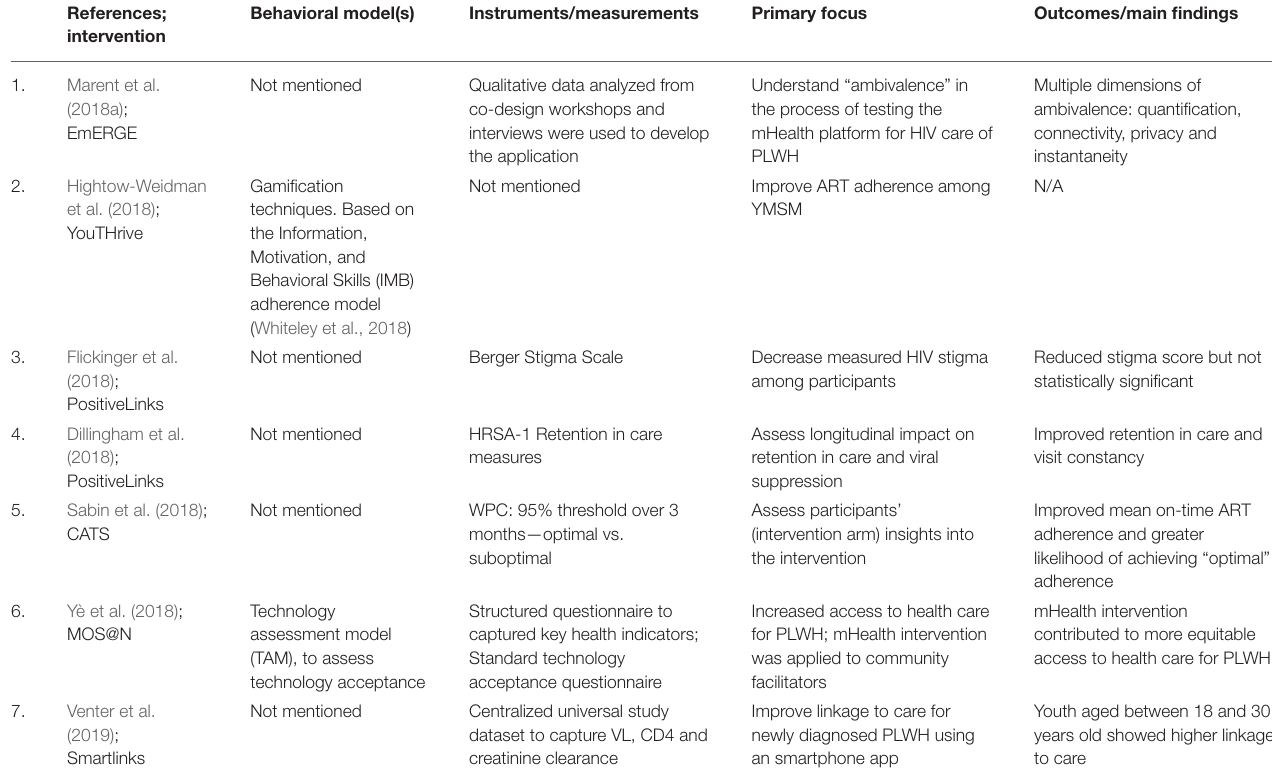
TABLE 3 | Summary of behavioral models, instrumentation, primary focus, and main findings for mHealth articles